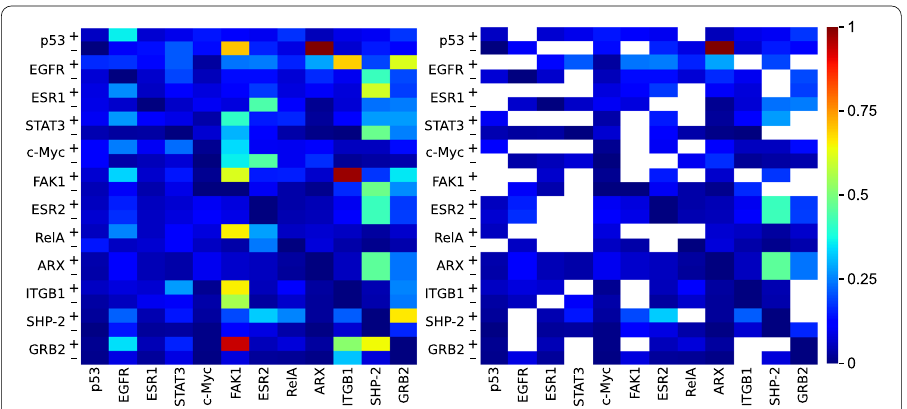
Fig. 5 Sum of the two matrix components G rr + G qr ( nd-block ) . The matrix components are the same as in Fig. 4 with the exception of G qr ( nd-block ) which is obtained from G qr by excluding 2 × 2 diagonal blocks, each one of these blocks corresponding to a protein self-loop. The right panel is the same as the left panel with the exception of the white cells which hide the direct links j → i between the 12 × 2 chosen nodes in the Ising MetaCore network. The values of the color bar correspond to the ratio of the matrix element over its maximum